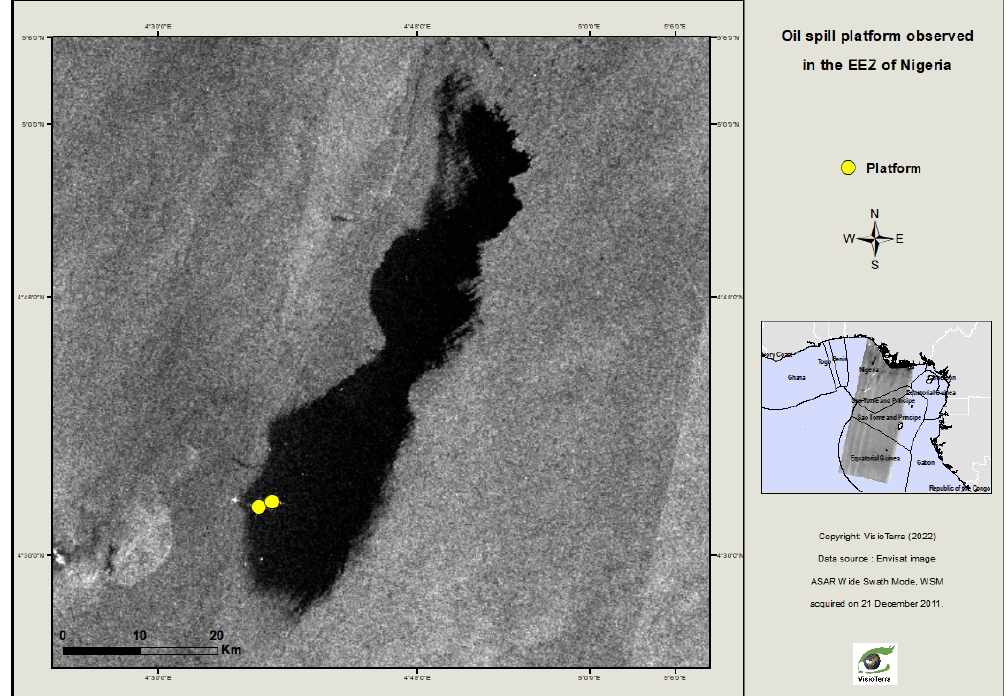
Figure 5. Oil spill from a platform observed in the EEZ of Nigeria (21 December 2011). The platforms are represented by the yellow dots (see hyperlook: http://visioterra.org/VtWeb/hyperlook/504c7208cc184c12b42ed036bc9912f3, last access: 13 October 2022).